Question: In a single sentence, describe what this figure presents.
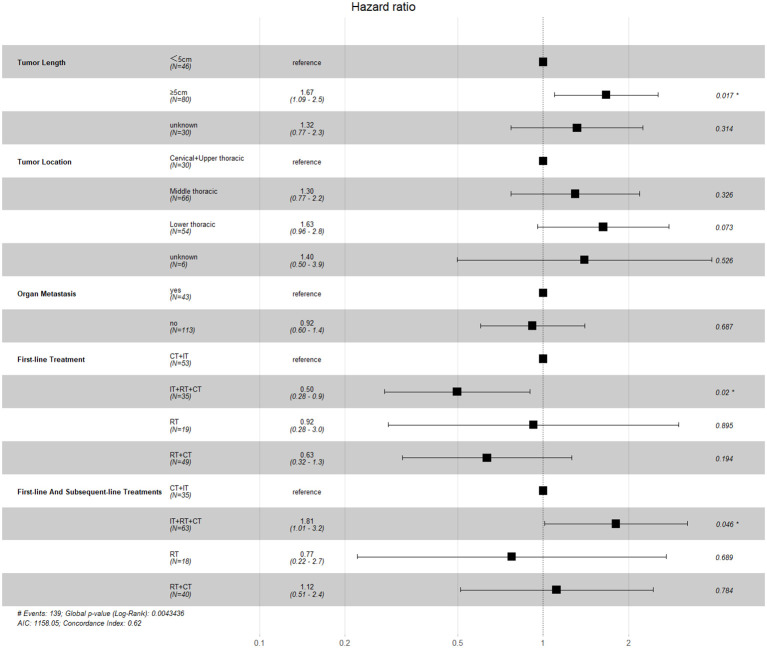
Answer: Multivariate Cox regression analysis for PFS of 156 recurrent and/or distant ESCC patients. * P < 0.05, ** P < 0.01.